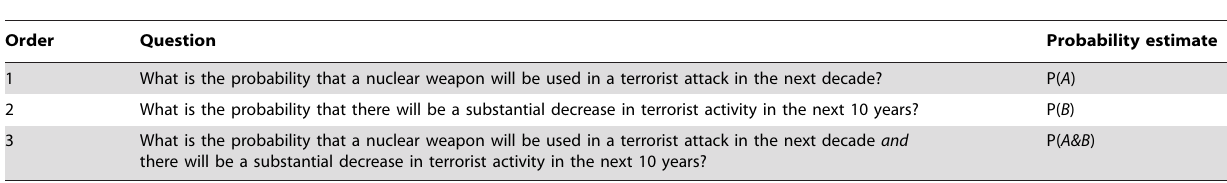
Order Question Probability estimate